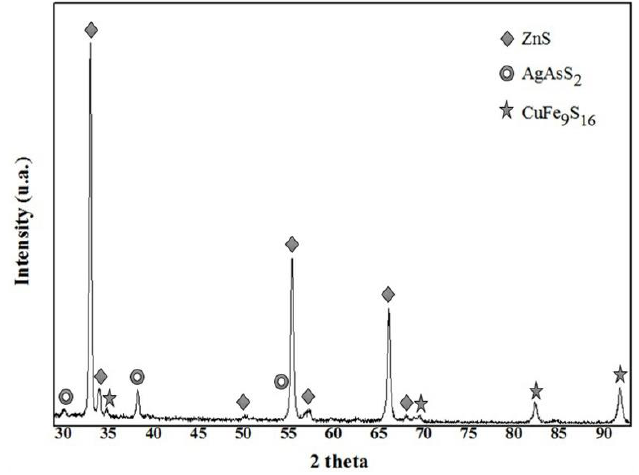
Figure 2. X-ray diffractogram of the powders of full-sized ore concentrate of Zn.